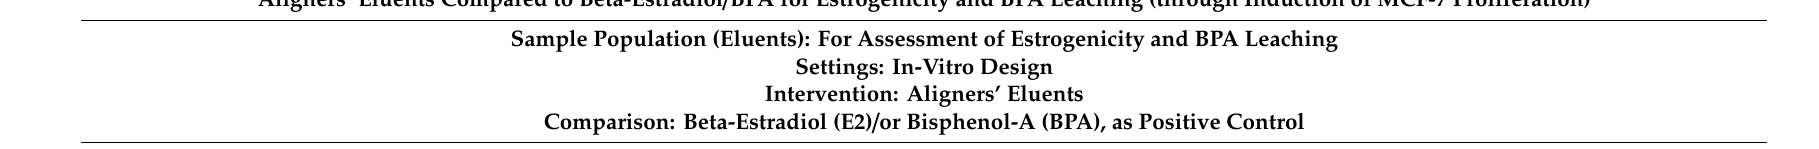
Table 4. Summary of Findings Table and quality of the evidence regarding aligners’ eluents capacity to induce MCF-7 cell proliferation. Aligners’ Eluents Compared to Beta-Estradiol / BPA for Estrogenicity and BPA Leaching (through Induction of MCF-7